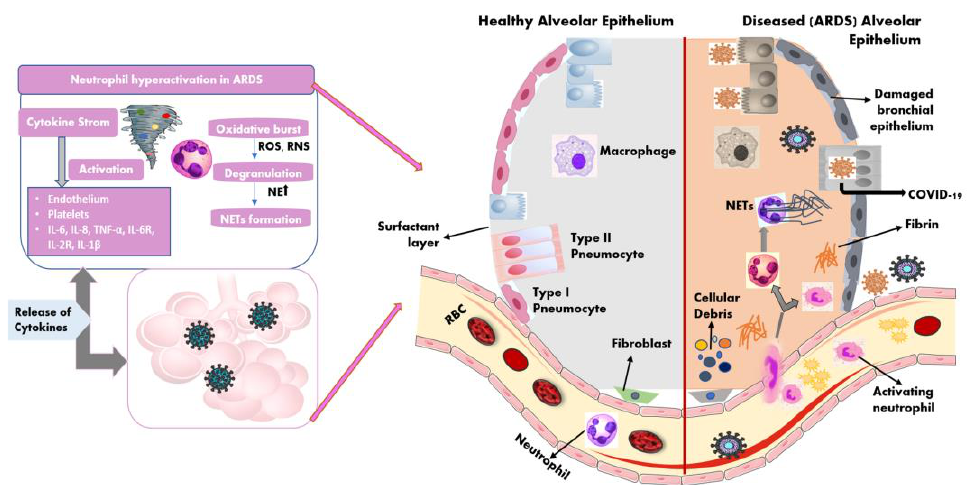
Figure 3. Neutrophils in lung tissue during SARS-CoV-2 infection and ARDS are depicted schematically. Neutrophil overexpression promotes cellular activities such as oxidation and cytokine production, as well as the production of multiple inflammatory mediators, including ROS, NE, NET formation, and various pro-inflammatory cytokines in an injured alveolar epithelium.